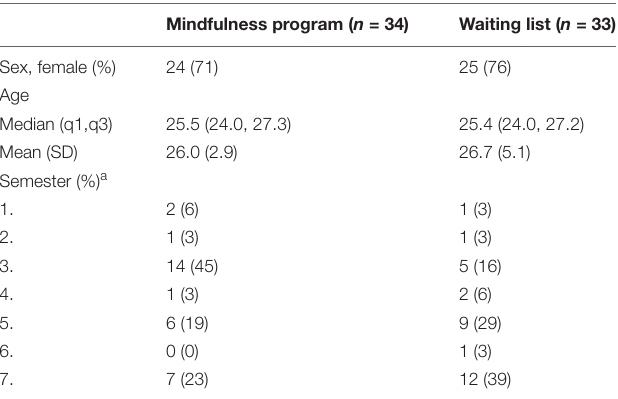
TABLE 1 | Characteristics of participants included in an RCT evaluating the effects of a mindfulness program including MBSR among students at VIA’s undergraduate program for teacher education ( n = 67), Denmark, 2019 and